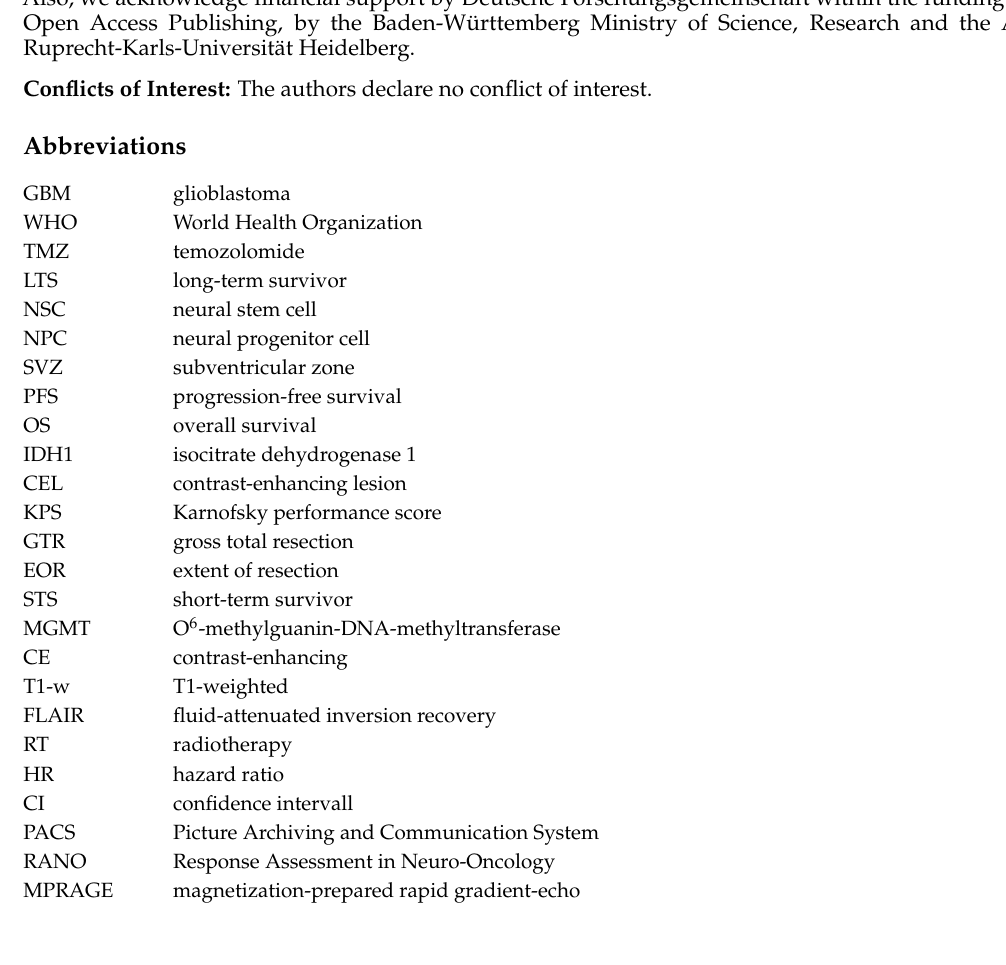
Table S1: Covariates included into the multivariate model, Table S2: Univariate Analysis of Survival Endpoints in the Complete IDH1-Wildtype Cohort ( n = 285), Table S3: Univariate Analysis of Survival Endpoints in Group II and Group III IDH1-Wildtype GBM ( n =